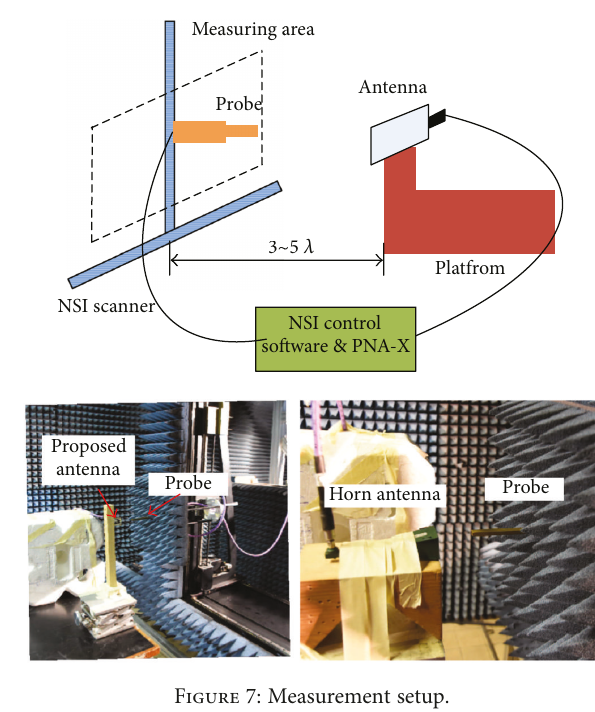
Figure 7: Measurement setup.